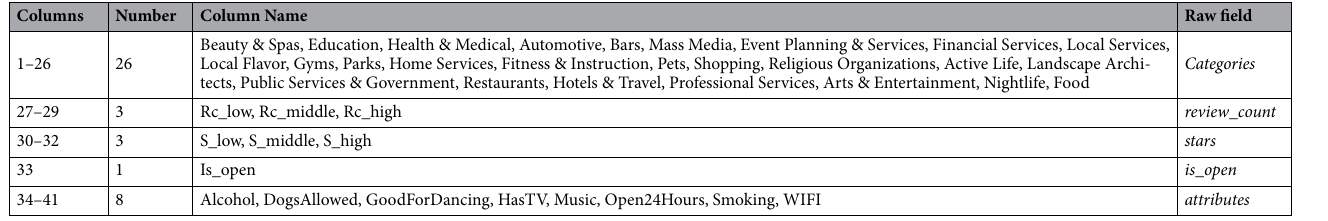
Table 1. The column structure of binary formal context from the Yelp business